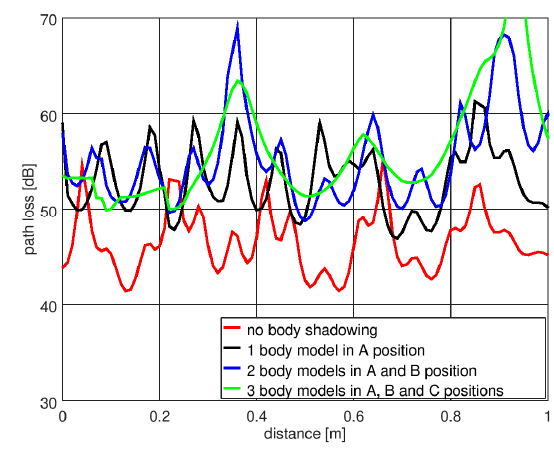
Figure 10. Results of path loss simulation for the indoor scenario in XGtd™.